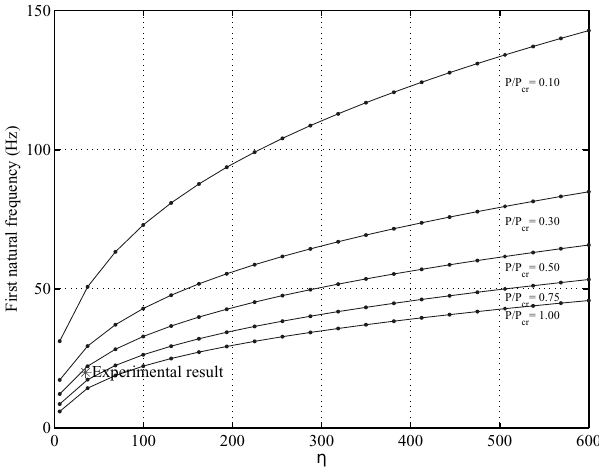
Fig. 12. Variation of the first natural frequency of the cantilever pile with respect to the normalized support stiffness for different values of axial load. The experimental result ( f 1 = 20 Hz, θ c = P/P cr = 0 . 5 and η = 35 . 0 ) is shown by a ‘*’ in the diagram. the foundation is fully liquefied (zero stiffness) which may represent some time instant after the onset of the shaking, and (c) the transient phase when the supporting soil is being transformed from being stiff to being liquefied. The experimental results indicate that the first natural frequency of the structure reduces as the soil starts to lose its stiffness (transient phase) and is lowest when the soil is in the fully liquefied condition. Bending, buckling and dynamics should be considered simultaneously to analytically model the real system. A distributed parameter model using the Euler Bernoulli beam theory with axial load, support stiffness and tip mass with rotary inertia is considered. The non-dimensional parameters necessary to understand the dynamic instability have been